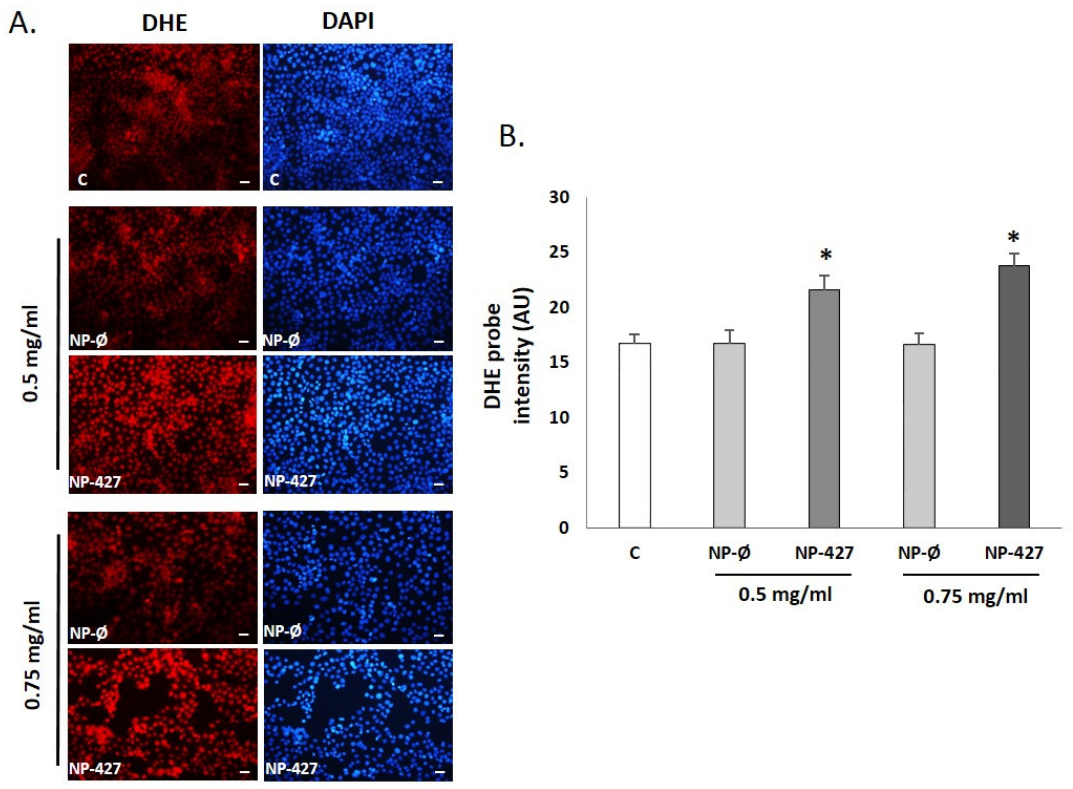
Figure 9. NP-427 increases the production of superoxide anion (O 2 − ) in FaDu cells. ( A ) Representative images of fluores- cence micrographs of the FaDu cells (×40). Scale bar 100 µm. ( n = 4). Superoxide anion detection with the fluorescent probe dihydroethidium, DHE (red fluorescent), and DAPI (a marker of the cell nuclei with blue fluorescent) dye in FaDu cultures. Experimental groups: C (control), NP-Ø (unloaded NPs, 0.5 and 0.75 mg/mL), and NP-427 (PHT427-loaded NPs, 0.5 and 0.75 mg/mL) for 24 h. ( B ) Quantification of fluorescence intensity for the DHE probe by ImageJ. The diagrams represent the mean ± SD of arbitrary units (AU). * p < 0.05 vs. their respective NP-Ø and control group ( n = 4).